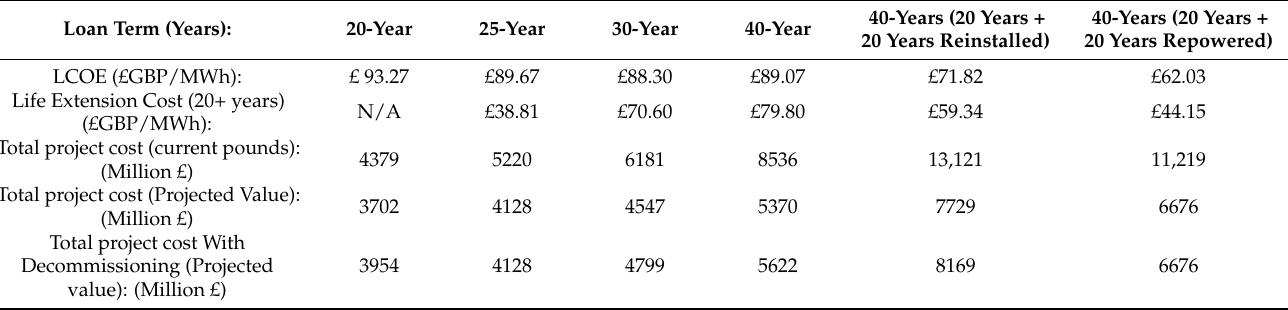
Table 4. Raw Model Data for London